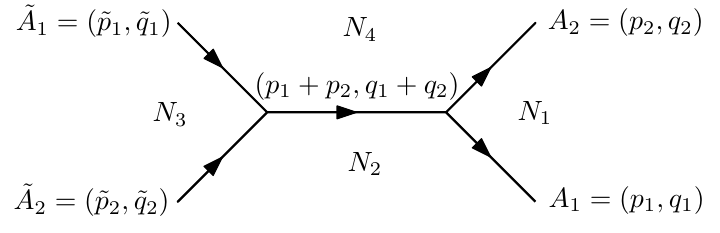
Figure 12. Gluing of two